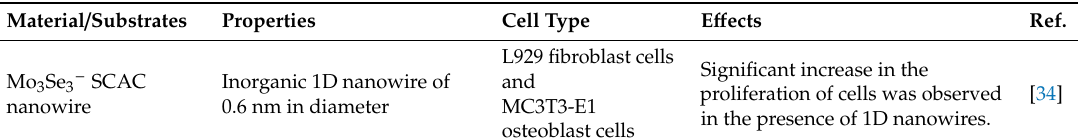
Table 2. Studies reporting the e ff ects of geometrical factors on